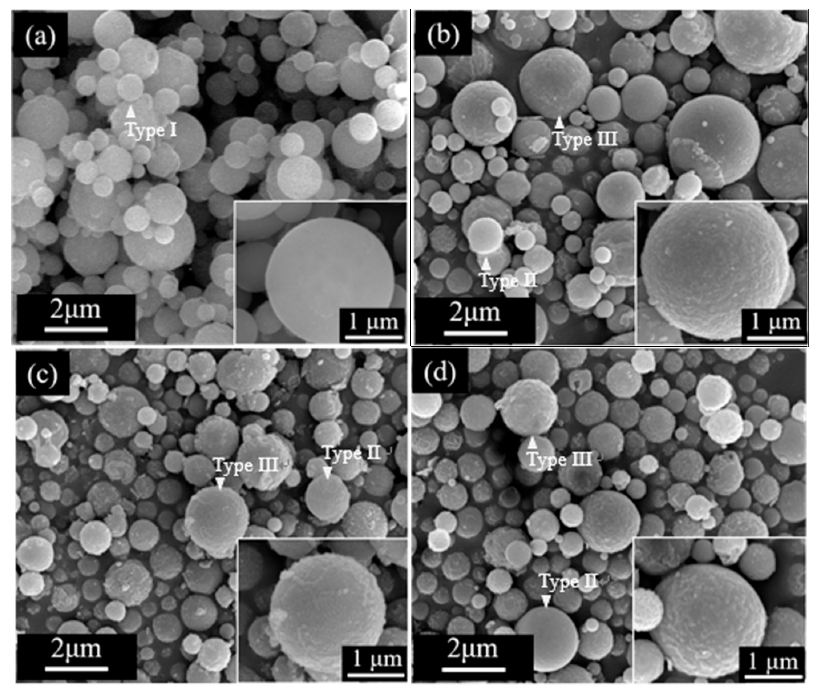
Figure 2. SEM images of ( a ) untreated BG powders, and ( b ) 1M, ( c ) 2M, and ( d ) 3M HAc-treated BG powders. The insets are the enlarged particles for corresponding morphologies.